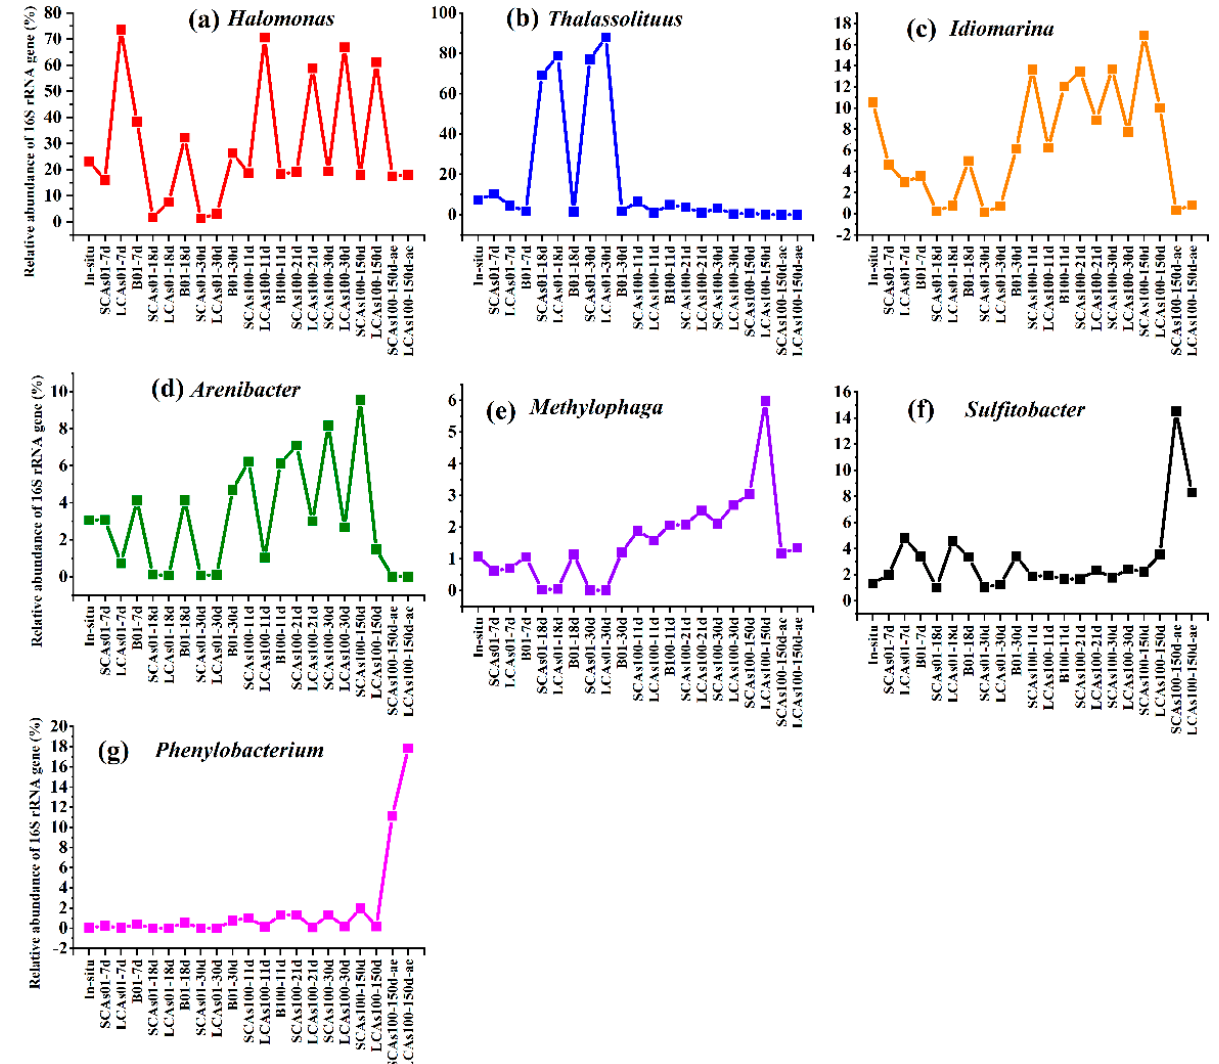
Figure 3. The top 7 genera in microbial communities in aerobic and anaerobic hydrocarbon enrichments at 0.1 and 100 MPa after incubated for 150 days. ( a ) The variations of relative abundance in Halomonas genus among different treatments and incubation time; ( b ) The variations of relative abundance in Thalassolituus genus among different treatments and incubation time; ( c ) The variations of relative abundance in Idiomarina genus among different treatments and incubation time; ( d ) The variations of relative abundance in Arenibacter genus among different treatments and incubation time; ( e ) The variations of relative abundance in Methylophaga genus among different treatments and incubation time; ( f ) The variations of relative abundance in Sulfitobacter genus among different treatments and incubation time; ( g ) The variations of relative abundance in Phenylobacterium genus among different treatments and incubation time.